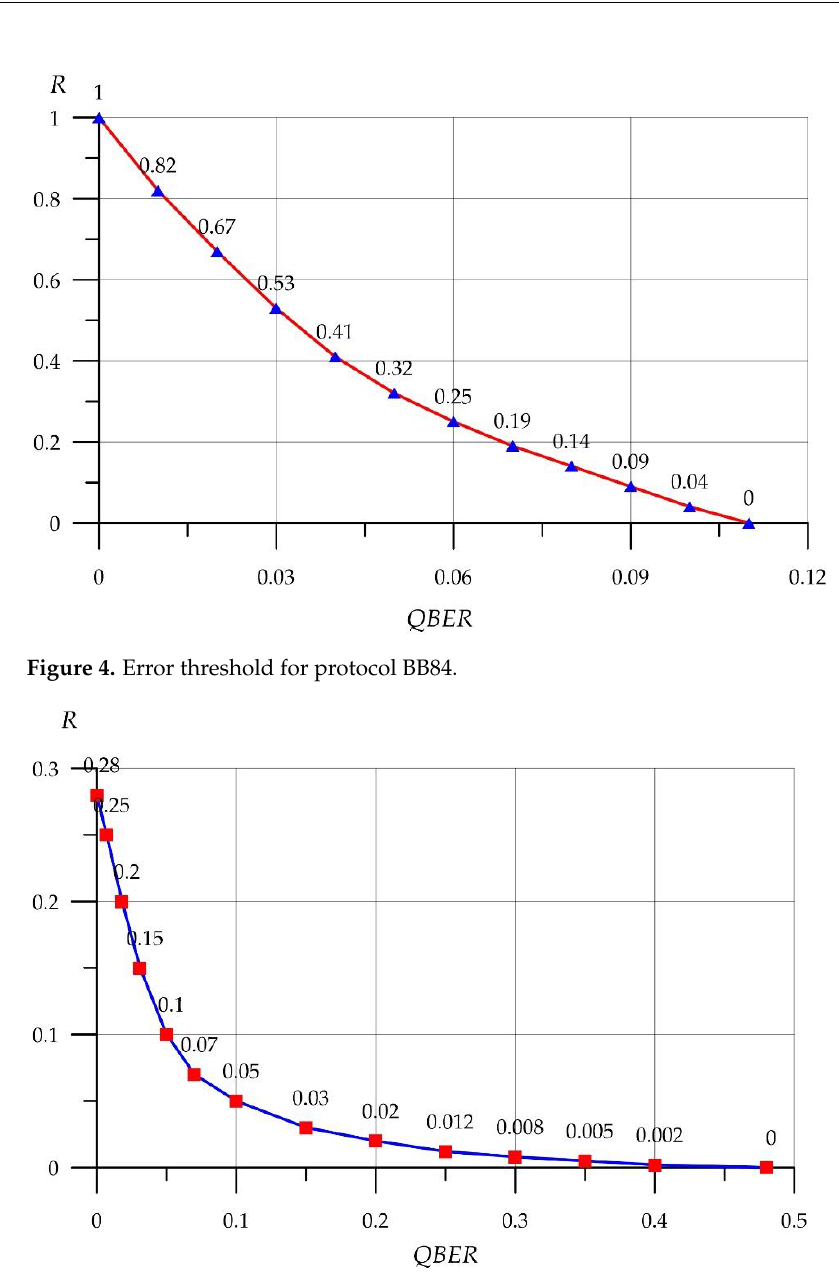
Figure 5. Safe zone of asymptotic rates of errors for BB84 – Info – Z protocol.